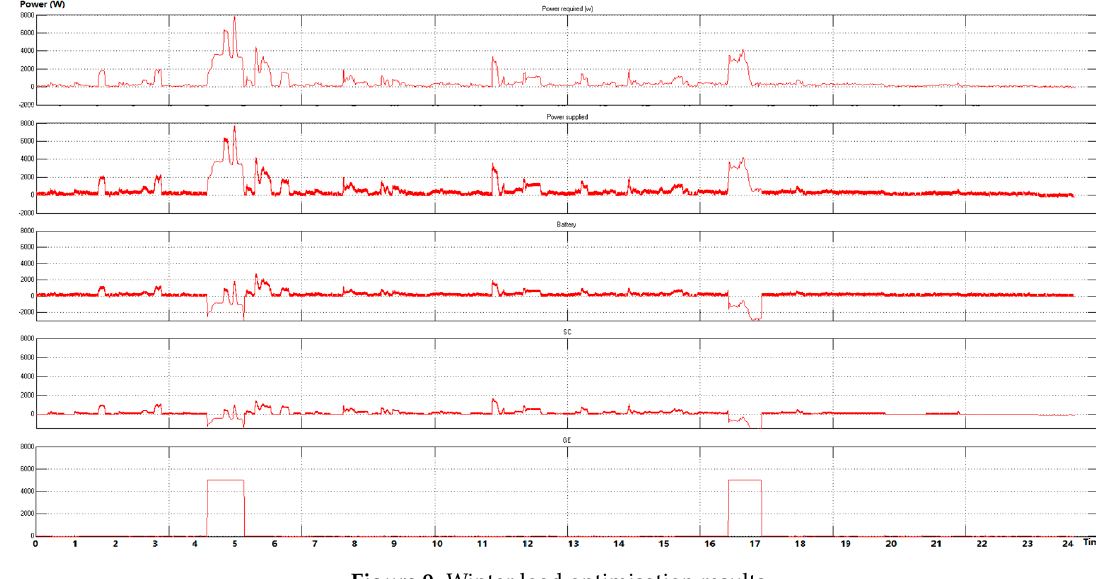
Figure 9. Winter load optimisation results. Table 2. Optimisation results summary.